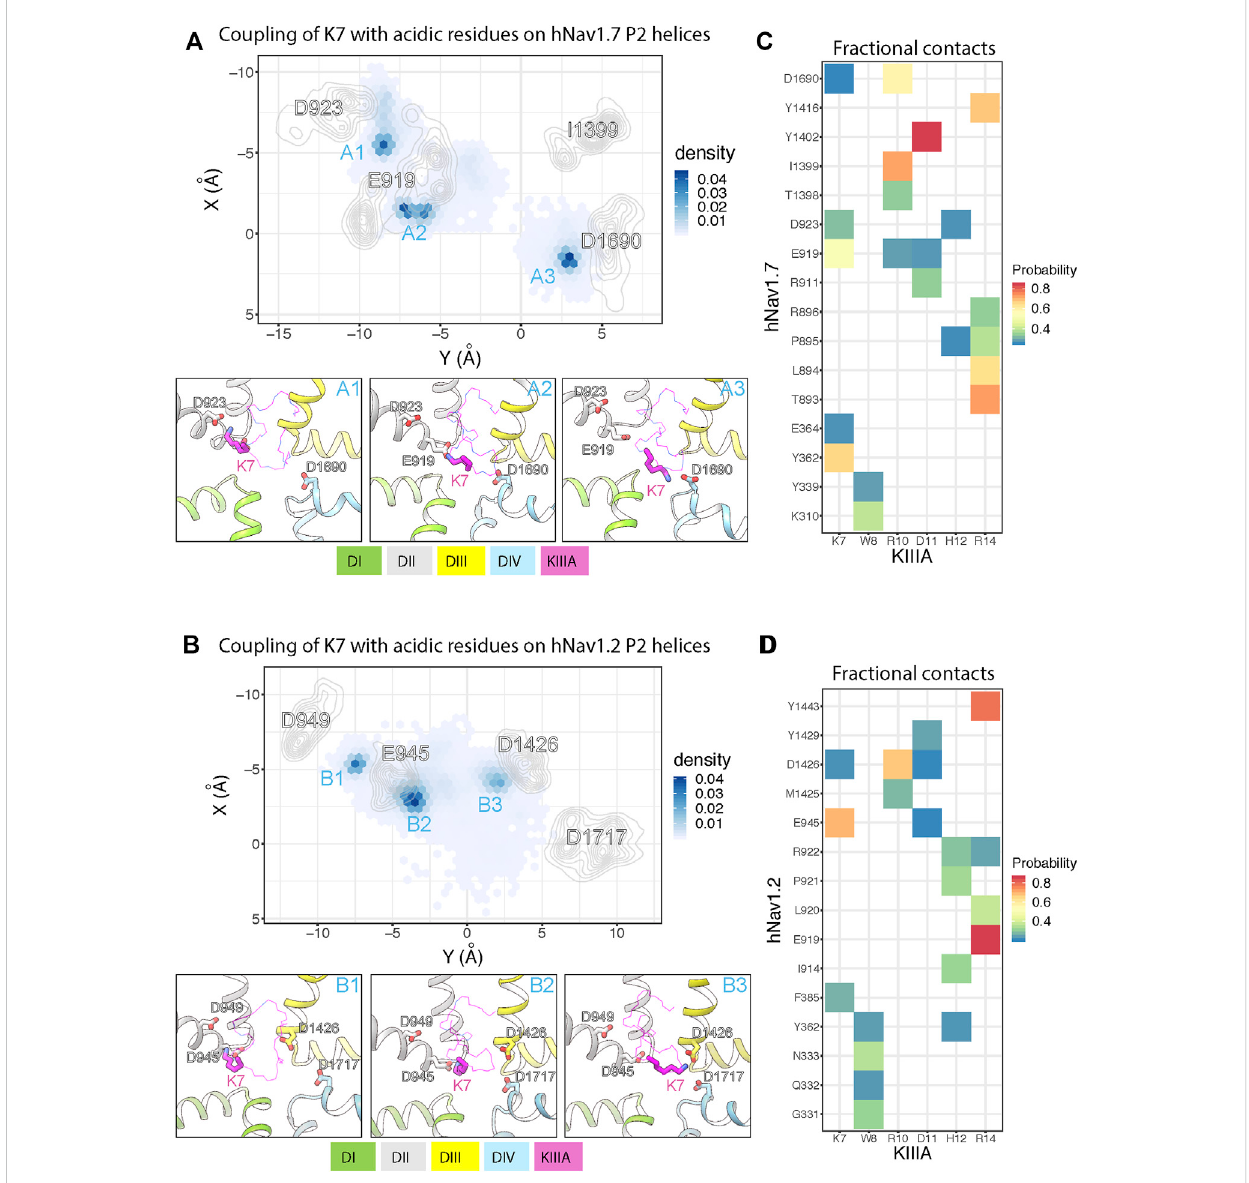
FIGURE 5 MD simulations of KIIIA — hNa V 1.7 and KIIIA — hNa V 1.2 complexes show structural dynamics of KIIIA interaction with hNa V 1.7 (A,C) and hNa V 1.2 (B,D) . (A,B) CouplingsofK7withkeyacidicresiduesonthehNa V P2 helices.DensityprojectionsofK7(Nitrogenatom) andtheacidic residue(oxygen atoms) on P2-helix (labeled) on the XY plane (upper panel). For clarity, densities of the acidic residues are shown as contour plots using kernel density estimation. Representative snapshotsshowinginteractionsofK7withtheacidicresiduesathighdensityregions(labeled)identi fi edfromthedensityprojections (lower panel). (C,D) Heatmaps showing fractional contacts between key residues on KIIIA and hNa V channels during the simulations.